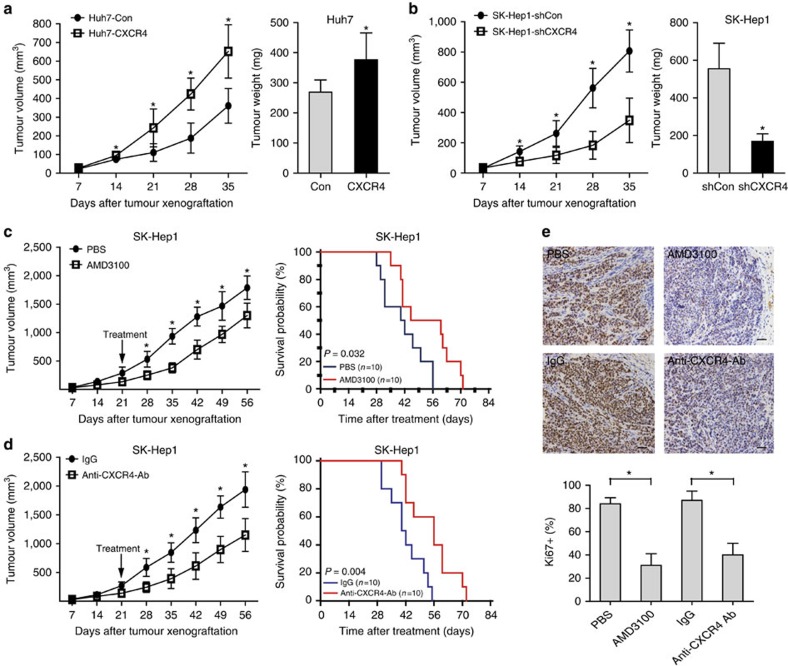
CXCR4 promotes hepatoma cells growth in vivo.(a) Tumour growth curve and quantification of weight of the tumours that developed in nude mice injected subcutaneously with Huh7-control or Huh7-CXCR4 cells (n=10). Student's t-test, *P<0.05. Error bars in panels are defined as s.d. (b) Tumour growth curve and quantification of weight of the tumours that developed in nude mice injected subcutaneously with SK-Hep1-shCon or SK-Hep1-shCXCR4 cells (n=10). Student's t-test, *P<0.05. Error bars in panels are defined as s.d. (c) Tumour growth curve of mice bearing SK-Hep1 xenografts following intratumoural administration of PBS or 10 mg kg−1 AMD3100 (n=10). Student's t-test, *P<0.05. Error bars in panels are defined as s.d. (left panel). Kaplan–Meier survival analysis was performed for above-mentioned xenograft mice (n=10), P value is determined by log-rank test (right panel). (d) Tumour growth curve analysis of mice bearing SK-Hep1 xenografts following administration of 1 mg IgG or anti-CXCR4 neutralization antibody (n=10). Student's t-test, *P<0.05. Error bars in panels are defined as s.d. (left panel). Kaplan–Meier survival analysis was performed for above-mentioned xenograft mice (n=10), P value is determined by log-rank test (right panel). (e) Representative IHC staining of Ki67 for SK-Hep1 xenografts with indicated administrations (scale bar, 50 μm; upper panel). Quantification of the percentage of Ki67-positive cells (n=10, lower panel). Student's t-test, *P<0.05. Error bars in panels are defined as s.d.